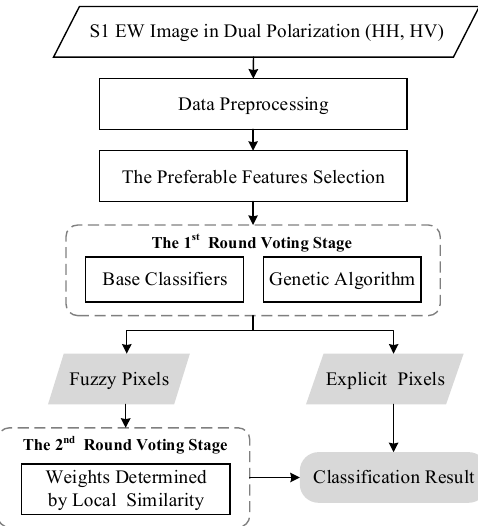
Figure 1. The overall architecture of the proposed method.